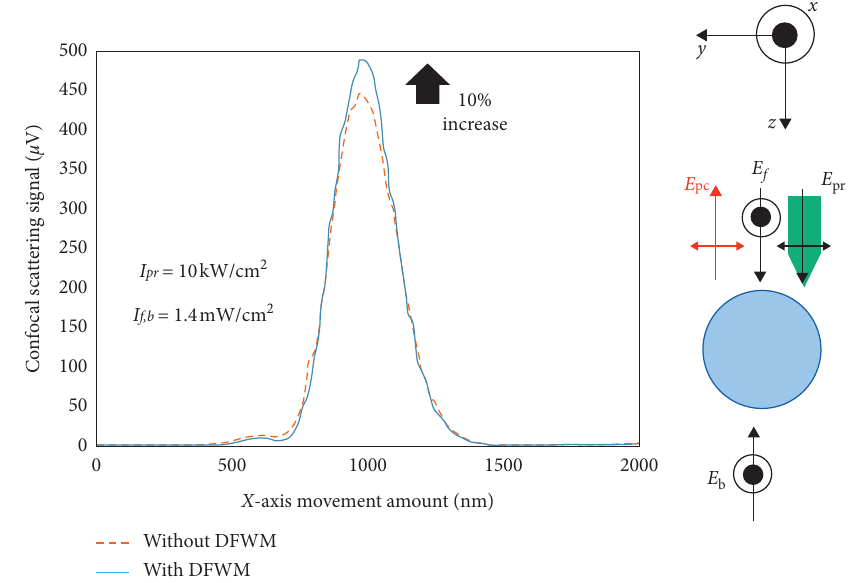
Figure 3: Confocal scattering signals from